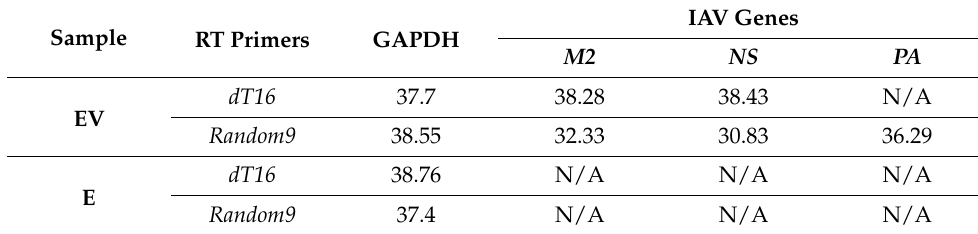
Table 2. RT-PCR cycle thresholds.